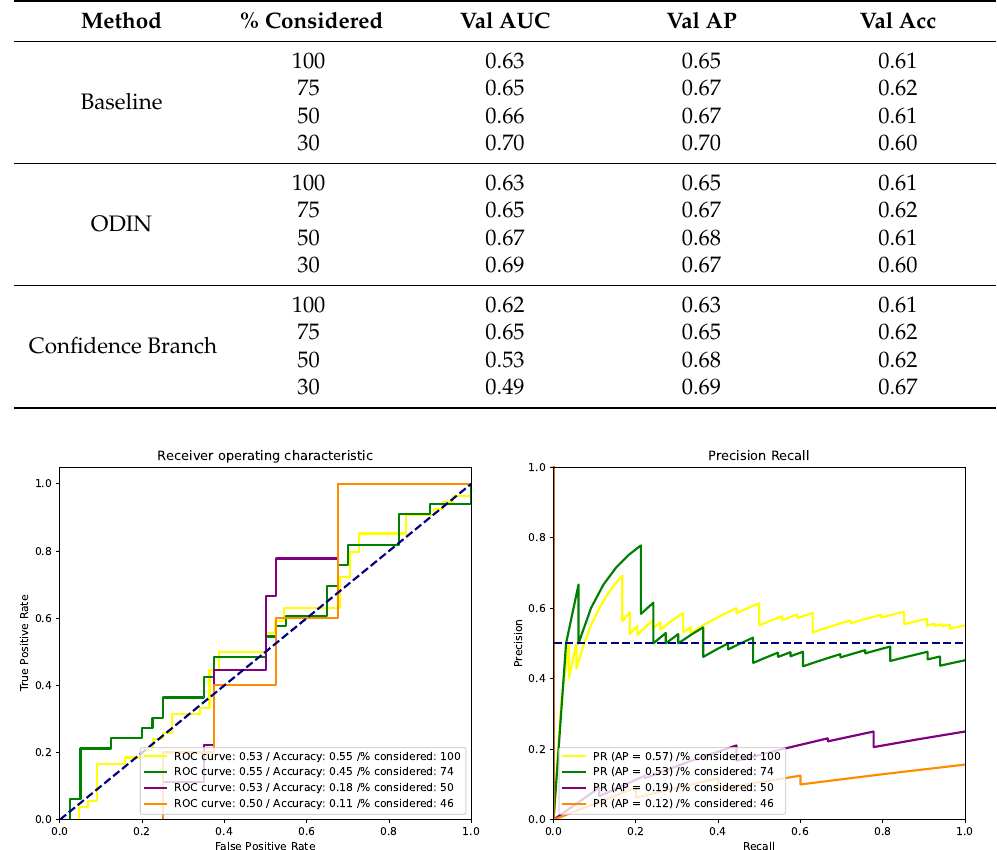
Figure A7. ROC and PR curves for the methylation percentage metric. Tumor-centered, FLAIR- T1wCE, early fusion. Table A6. Results of confidence metrics on the validation set. FLAIR-T1wCE, intermediate fusion.